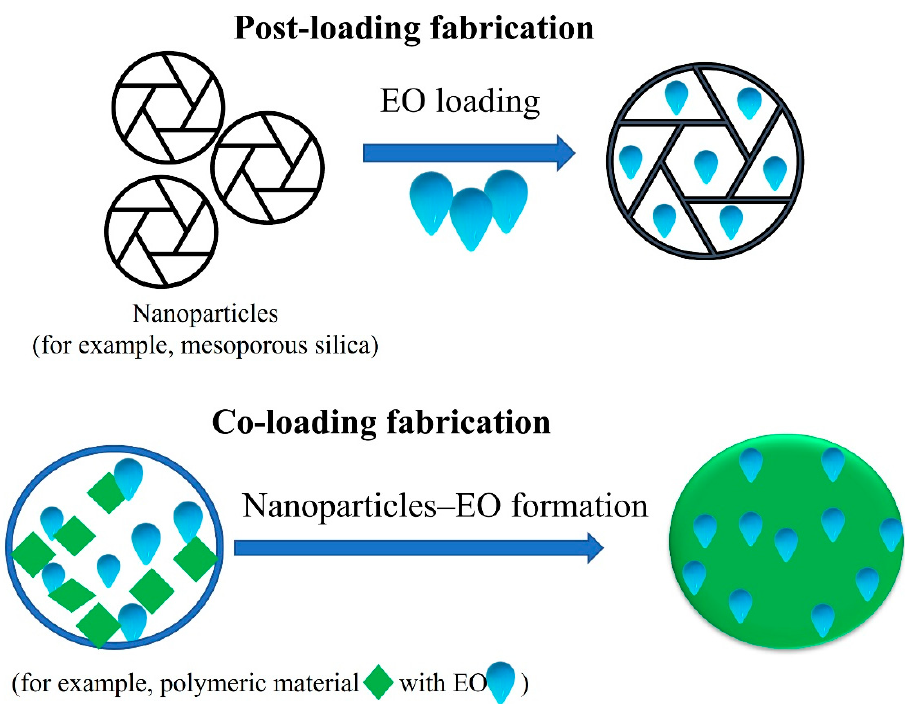
Figure 6. Schematic representation of two loading strategies that can be efficiently used for EO nanoformulations: post-loading fabrication and co-loading fabrication. The first approach is more likely for inorganic materials, and second approach is more likely for organic materials.